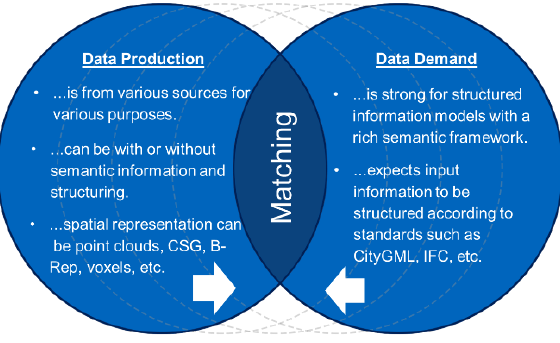
Figure 1 Role of evaluation in bridging the gap between data production and data